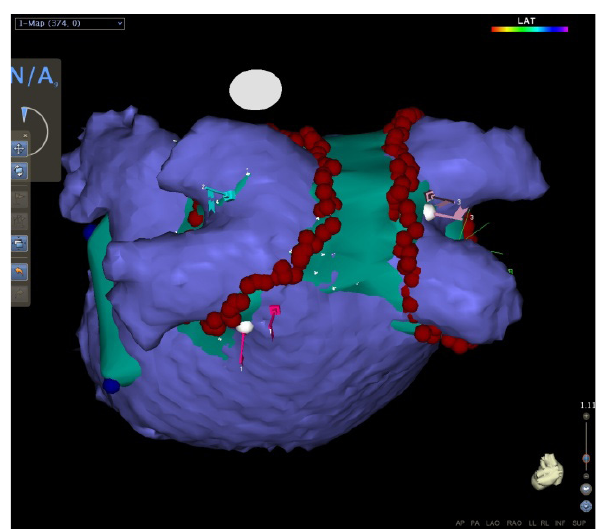
Fig. 1. CARTO3 anatomical model of left atrium. Wide encir- cling lesions around ostia of ipsilateral pulmonary veins. Red dots = ablated areas.